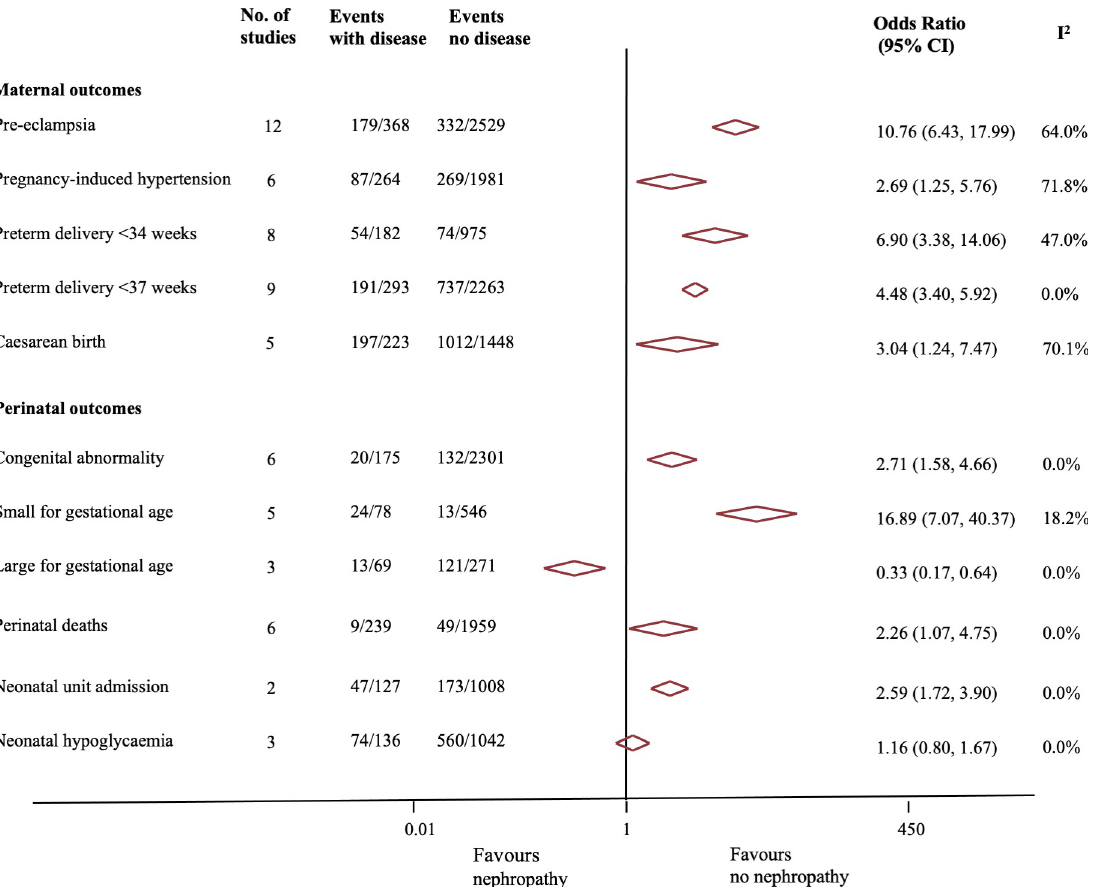
Fig 3. Association between diabetic nephropathy and adverse maternal and perinatal outcomes.